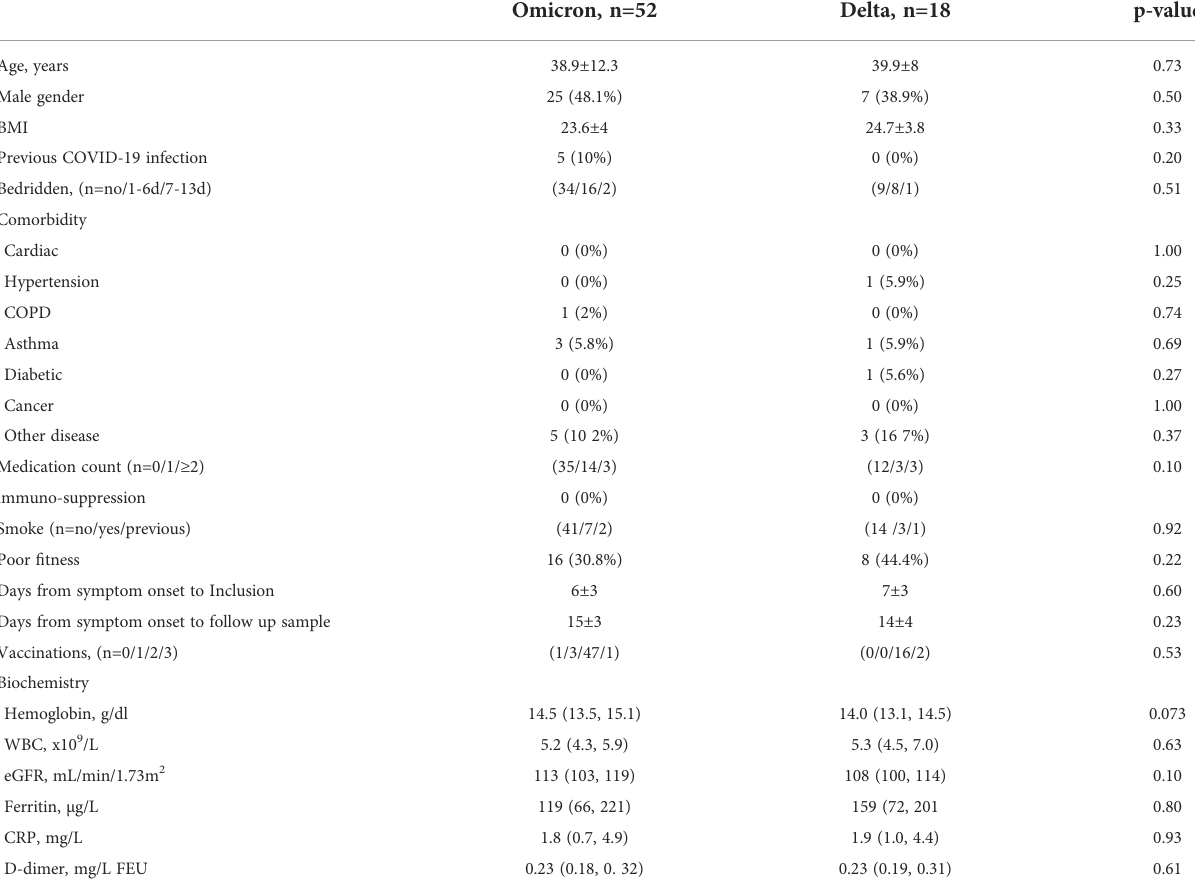
TABLE 1 Demographics, clinical characteristics, and laboratory fi ndings at